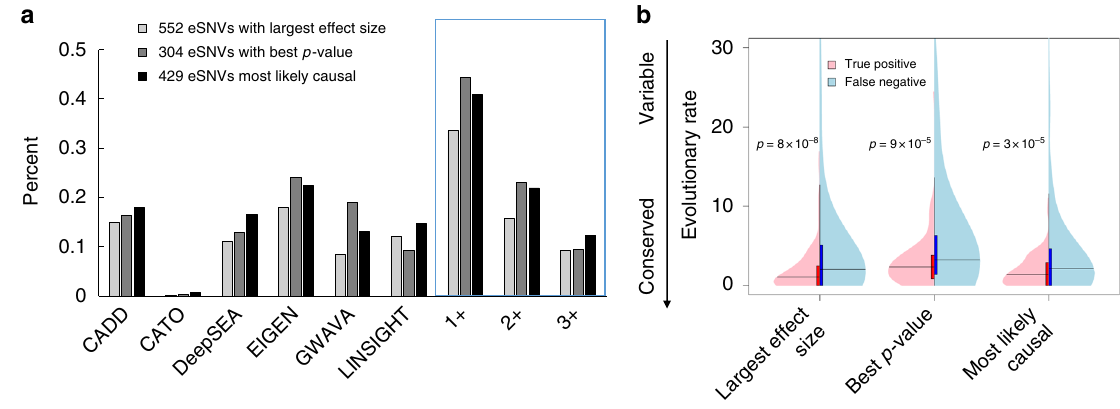
Fig. 5 Performance of six methods for diagnosing eSNVs. In order to determine cutoff scores beyond which GTEx variants are classi fi ed as non-neutral, we selected the score cutoff that maximized balanced accuracy (TPR + TNR) on the DAV-vs-CPP dataset for each tool (Supplementary Table 2). a Proportion of eSNVs predicted as functionally non-neutral by each method and by at least one (1 + ), two (2 + ), or three (3 + ) methods. b Violin plots showing distributions of positional conservation, as measured by evolutionary rate. True positives are eSNVs predicted as functionally non-neutral by at least one method. False negatives are eSNVs predicted as functionally neutral by all six methods. Student t -tests were performed to compare evolutionary rates between true positive and false negative samples in each set. p -values are